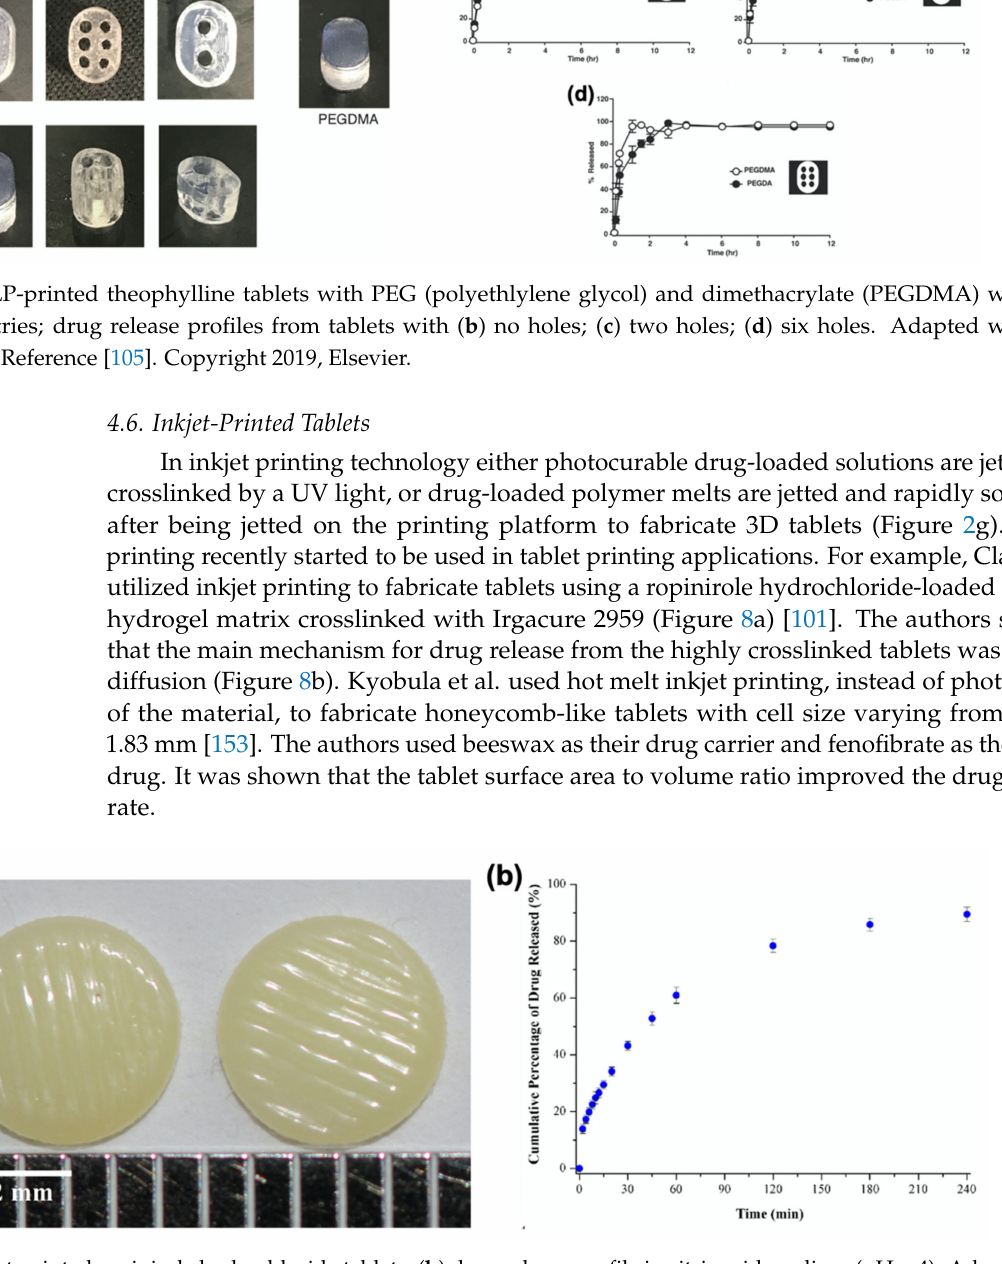
Figure 8. ( a ) Inkjet-printed ropinirole hydrochloride tablets; ( b ) drug release profile in citric acid medium (pH = 4). Adapted with permission from Reference [101]. Copyright 2017,